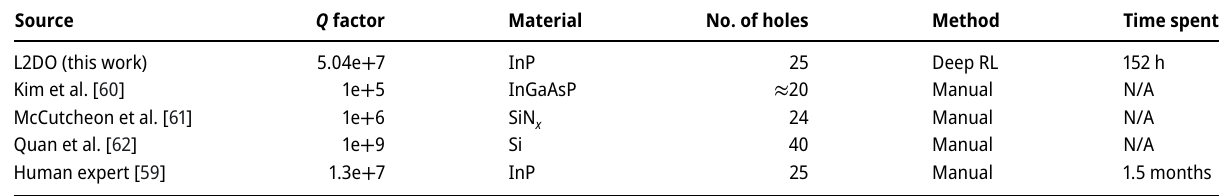
Table 3: Comparison of results in this work to best baselines from the literature as well as a human expert. Only the Q -factor is used as the performance metric here. The long nanobeam is chosen as the representative because its number of holes is similar to the baseline models.